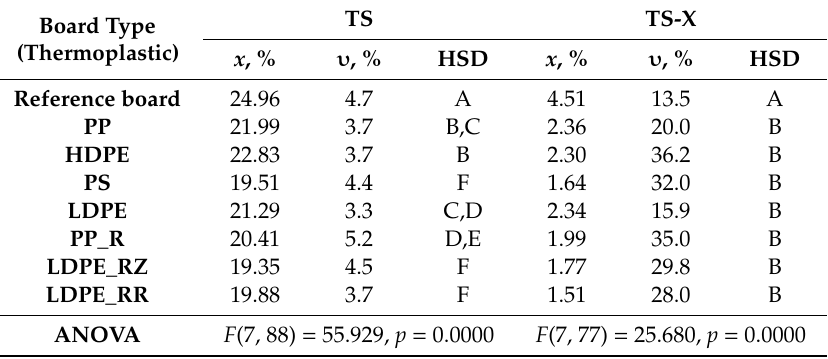
Table 5. E ff ects of the thermoplastics on board swelling after immersion in